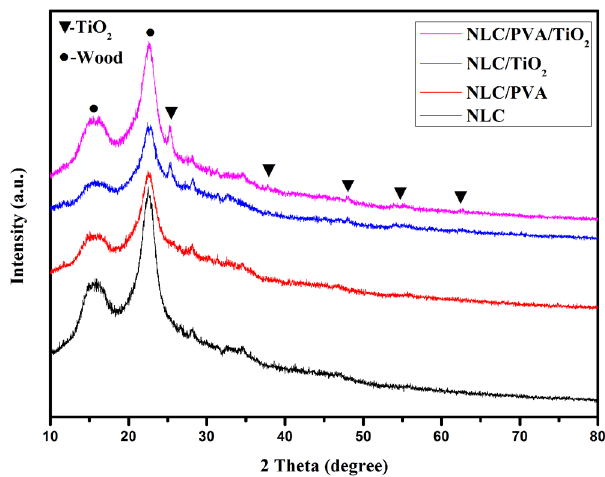
Figure 3. The XRD patterns for the NLC, NLC/PVA composite, NLC/TiO 2 composites and NLC/PVA/TiO 2 (Fig. 2b) and was composed of randomly entangled nanowires (Fig. 2c). As shown in the HRTEM image (inset of Fig. 2c), the pure NLC typically had diameters of 50–100 nm, these were stacked with each other through van